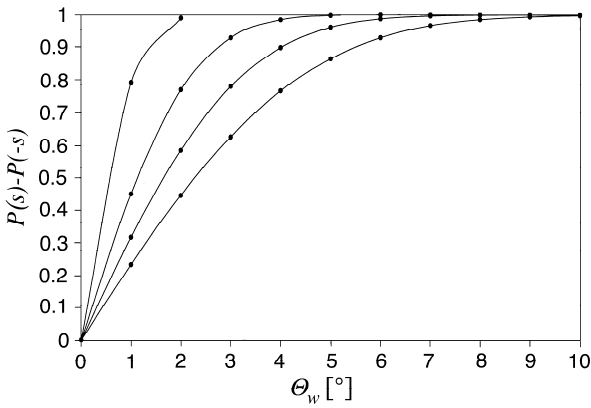
Fig. 4. The cumulative probability P(s) − P( − s) as a function of the nadir angle θ w in water corresponding to s . The curves represent from top to bottom the wind speeds 0, 2, 5 and 10ms − 1 .